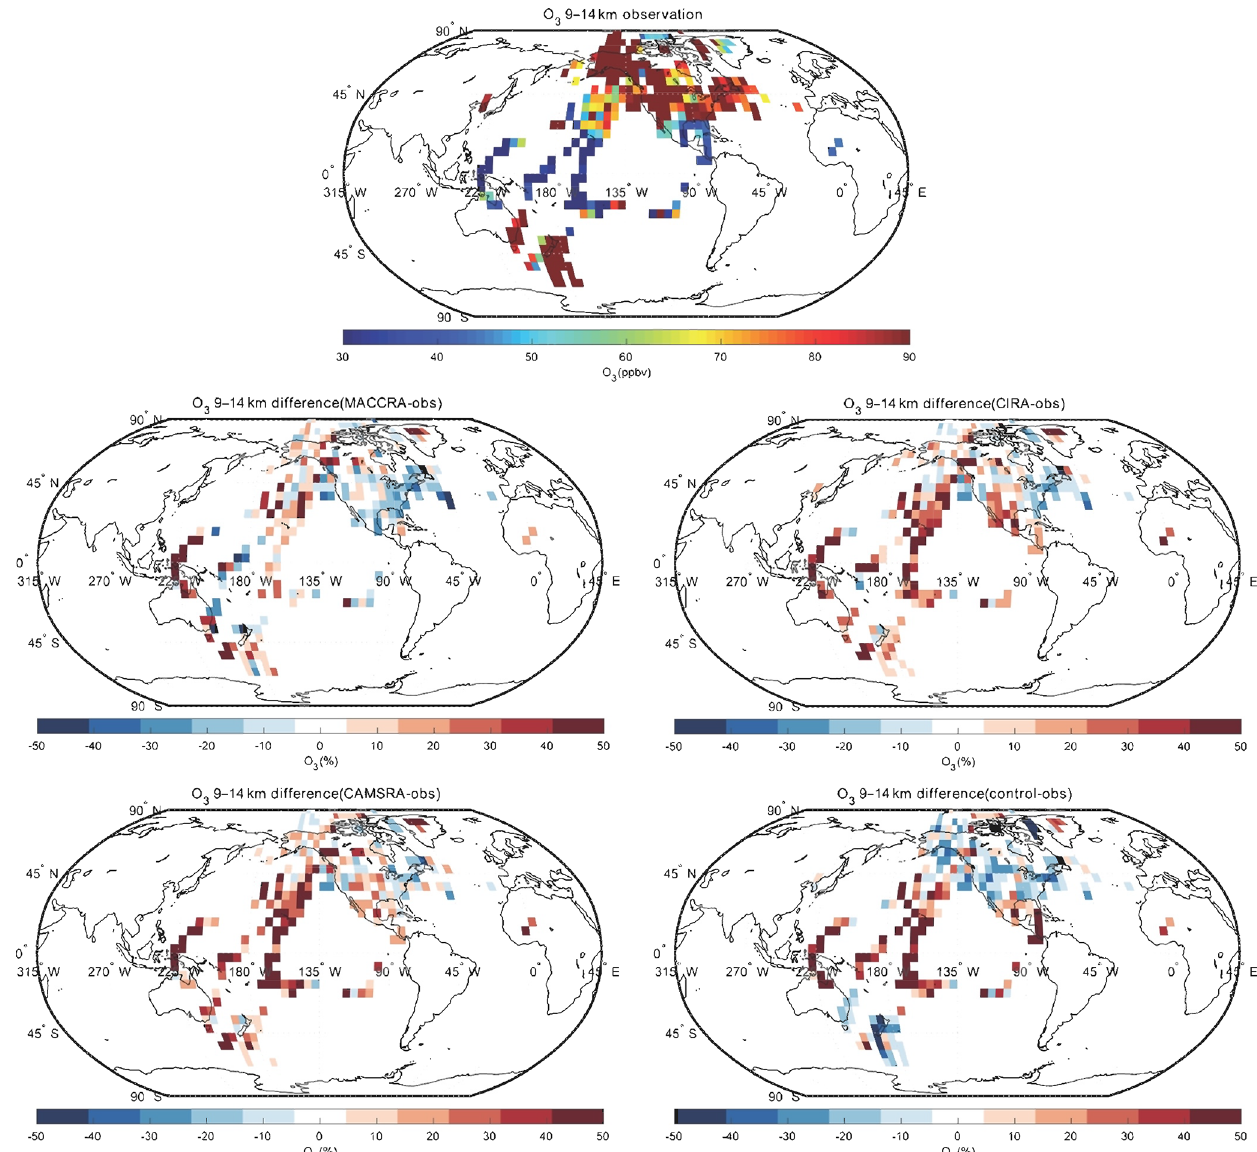
Figure 4. Same as Fig. 2, but for the altitude bin of 9–14km.